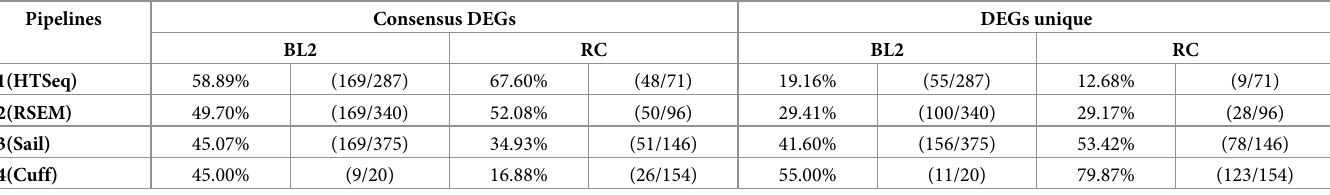
Table 3. Overview of the proportion of genes and corresponding percentage of differential expressed genes for each pipeline after multiple testing adjustment. Pipelines